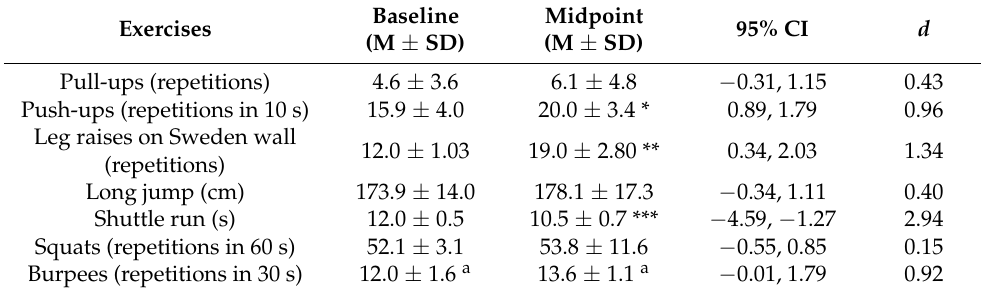
Table 1. Changes in physical fitness of 10–12-year-old judokas in the experimental group from baseline to mid-point test ( n = 8).